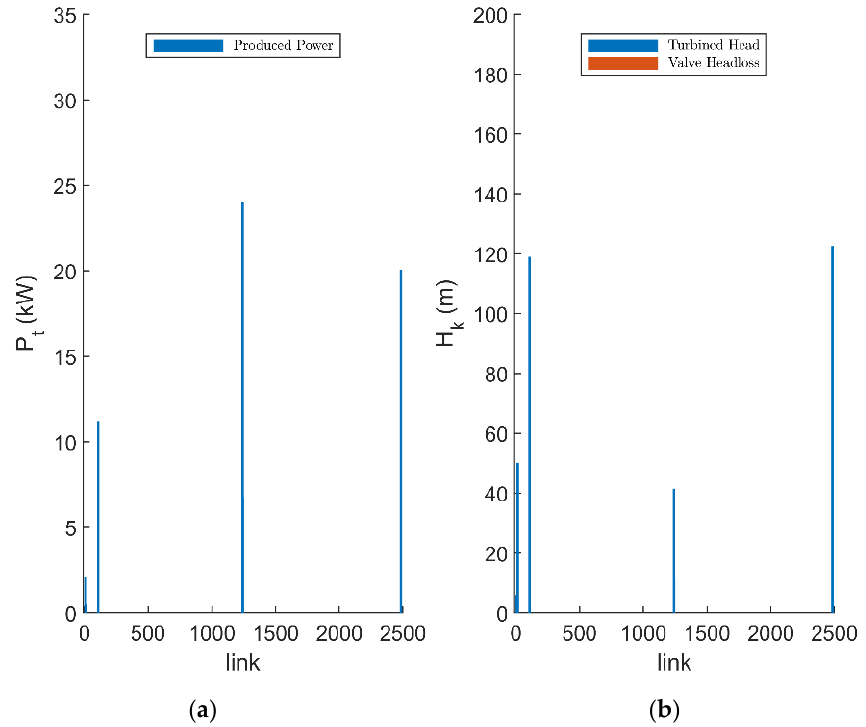
( a ) ( b ) Figure A2. Produced power of the installed turbines ( a ) and head drop within the devices ( b ) resulting from case (II).